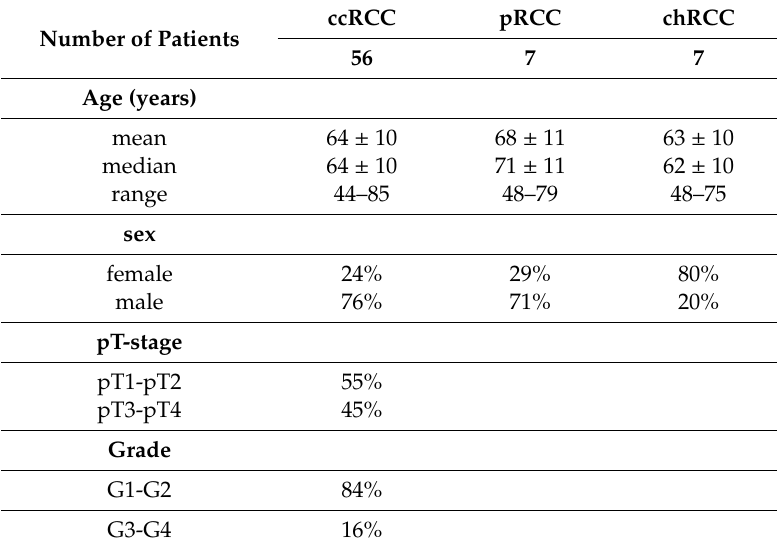
Table 1. Patient cohort. The patient cohort is composed of 64 patients, grouped into three major renal tumor types ccRCC, pRCC, and chRCC. Patient parameters age, sex, pT-stage and grade are depicted in the